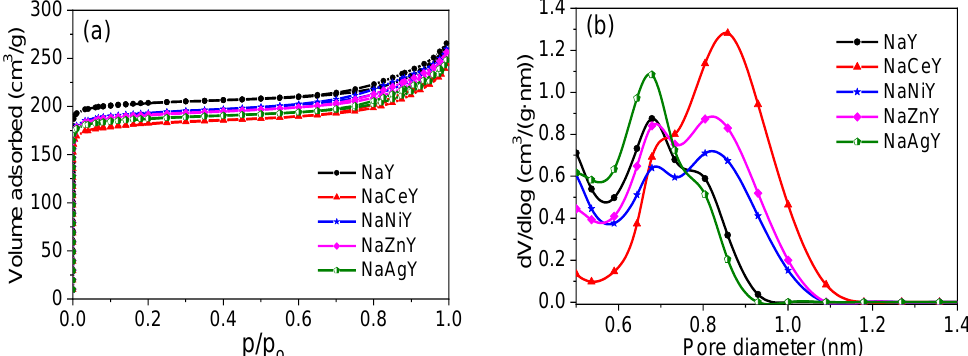
( b ) Figure 4. TG ( a ) and DTG ( b ) curves of different Y zeolites.